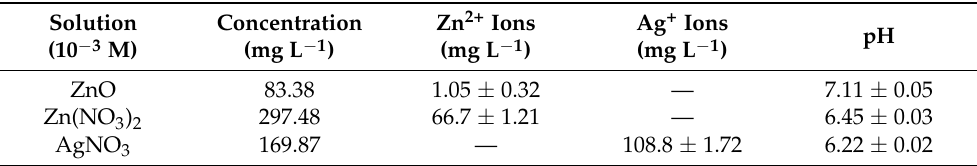
Table 2. pH and Zn 2+ and Ag + ion ions concentrations of the aqueous solutions and their pH, used for electroless deposition.